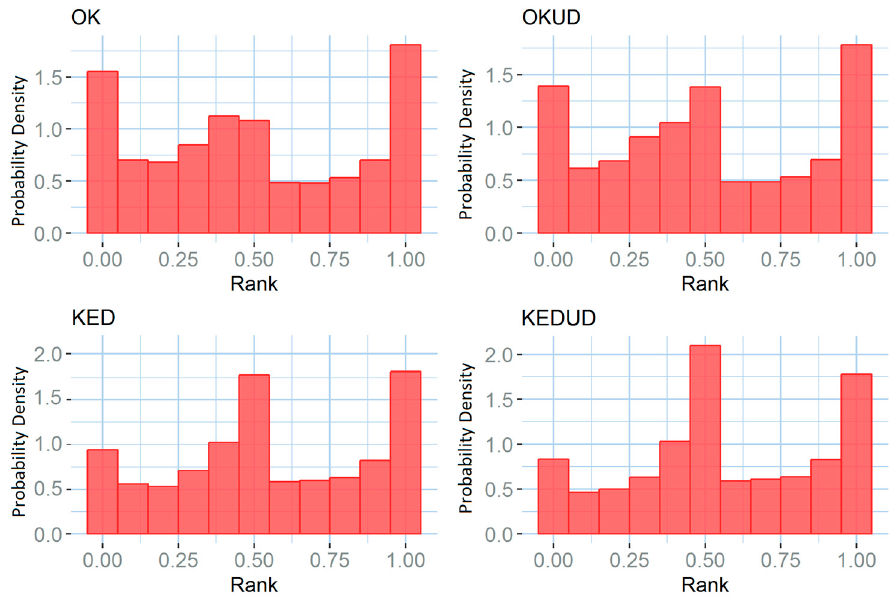
Figure 4. Rank histograms relative to the four studied rainfall products.